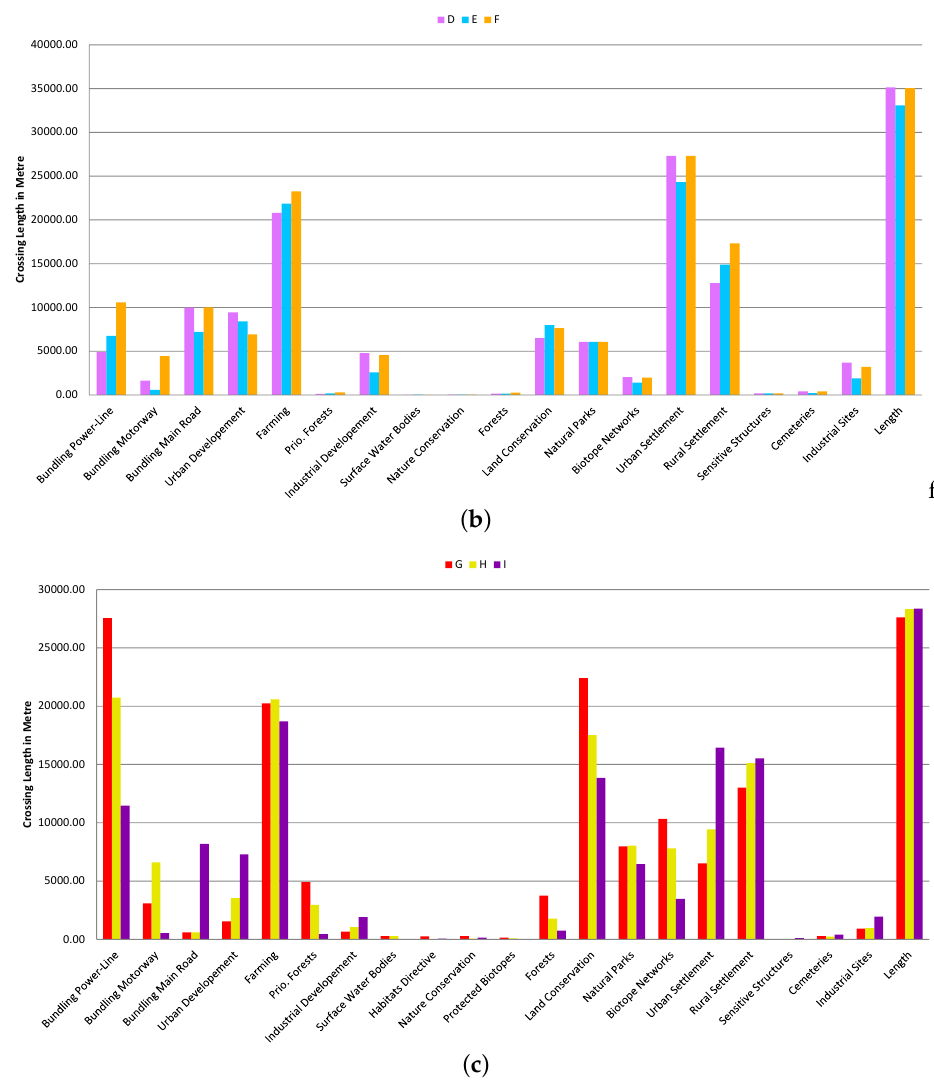
Figure 7. Crossing length for the identified alternatives (cf. Figure 9). Criteria with zero crossings were omitted. ( a ) scenario 1 “Settlement” with Alternatives A , B , C ; ( b ) scenario 2 “Environment” with Alternatives D , E , F ; ( c ) scenario 3 “Bundling” with Alternatives G , H , I